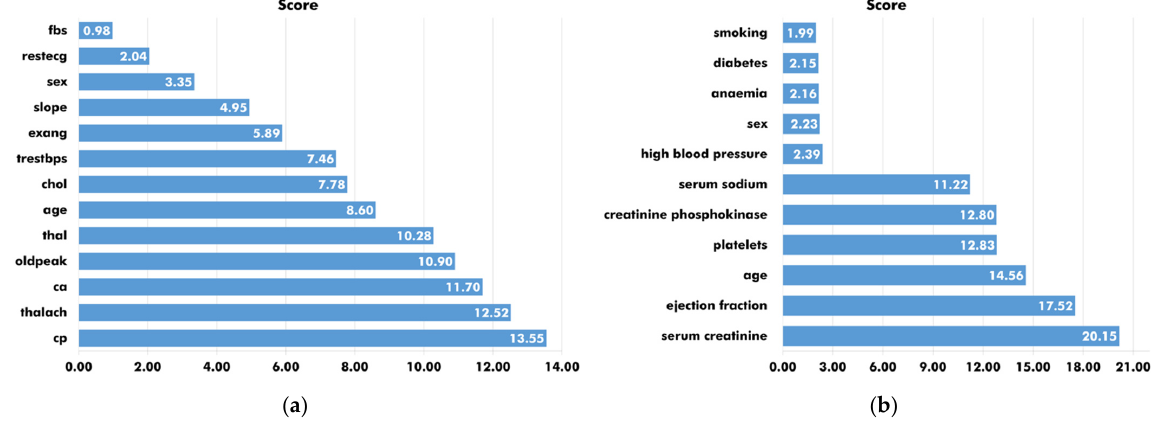
Figure 2. Ranking of attributes selected by Random Forest for CVD prediction on ( a ) Cleveland dataset and ( b ) Faisalabad dataset.